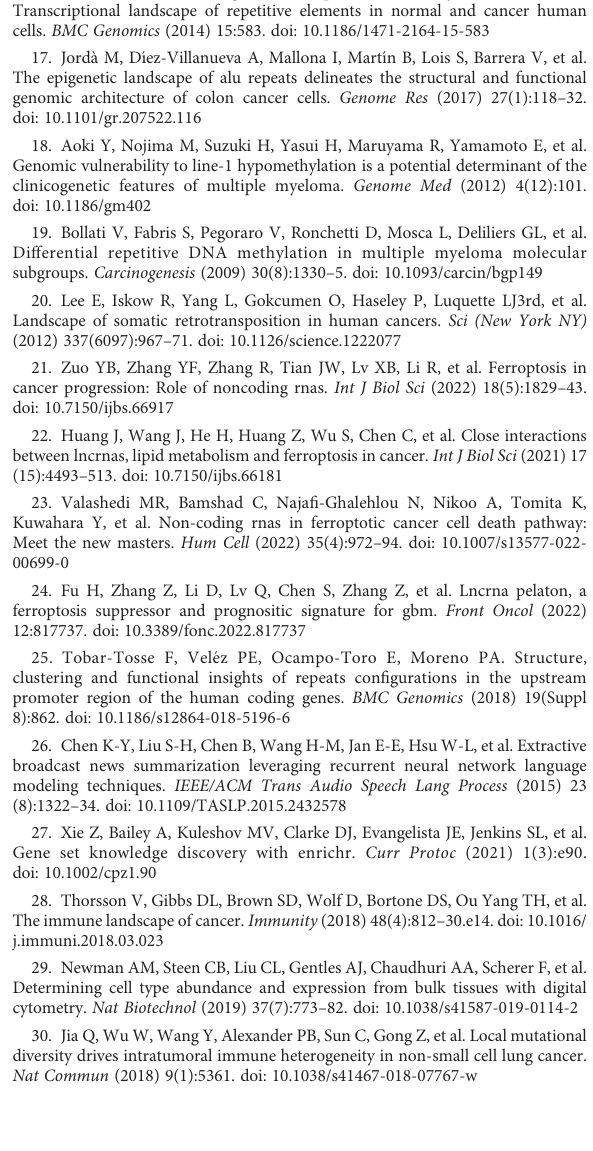
SUPPLEMENTARY FIGURE 8 CellcompositionoftumormicroenvironmentinvestigatedbyCIBERSORT. (A) Cell compositionof Bonemarrow (B) Non-plasmacell composition. SUPPLEMENTARY FIGURE 9 GSEA result of KEGG gene set based on the risk-score of each multiple myeloma patients. (A) Proteasome (B) Cysteine and methionine metabolism (C) p53 signaling pathway (D) DNA replication (E)